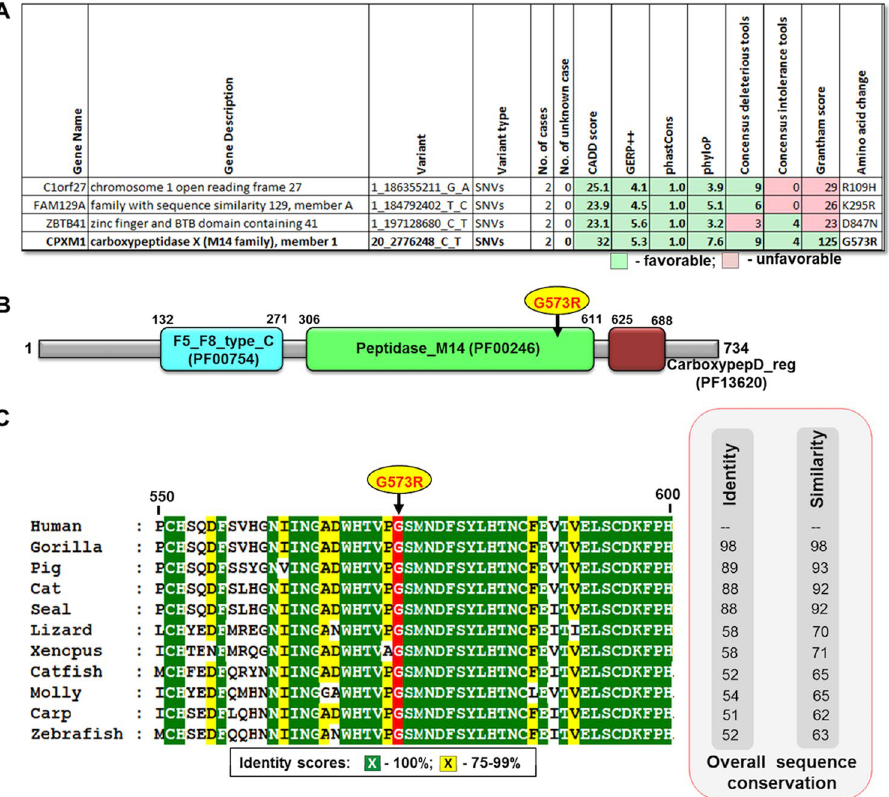
Figure 4. Overview of the top missense variants in the PTC family. ( A ) The 4 top ranked variants are shown with their favorable and unfavorable features. Grantham scores - 0–50 - conservative, 51–100 - moderately conservative, 101–150 - moderately radical and ≥ 151 - radical. ( B ) Location of the G573R variant in the peptidase M14 domain of CXPM1. ( C ) The G573R variant is localized in a highly conserved region. CXPM1 protein sequences were downloaded from GenBank as human (GenBank ID - NP_062555.1), gorilla (XP_004061758.1), cat (XP_003983774.1), pig (XP_003134381.1), seal (XP_021544821.1), lizard (XP_008120663.1), Xenopus (XP_002936314.1), catfish (XP_017320329.1), carp (XP_018934262.1), molly (XP_014844715.1) and zebrafish